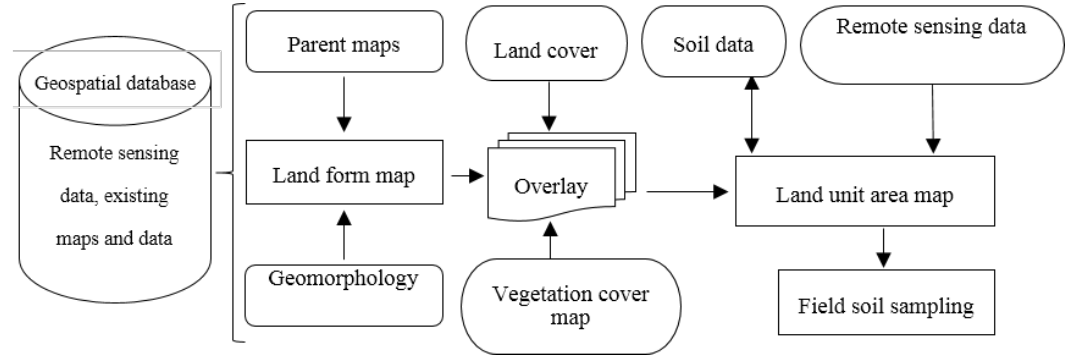
Figure 3. The flowchart of GIS frame work for creating the land unit area map.